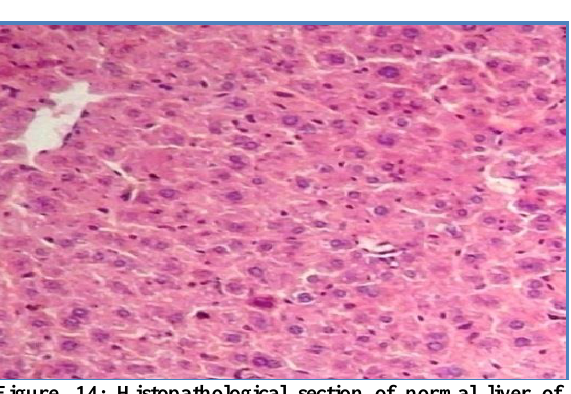
Figure, 14: Histopathological section of normal liver of mice. (H and E,